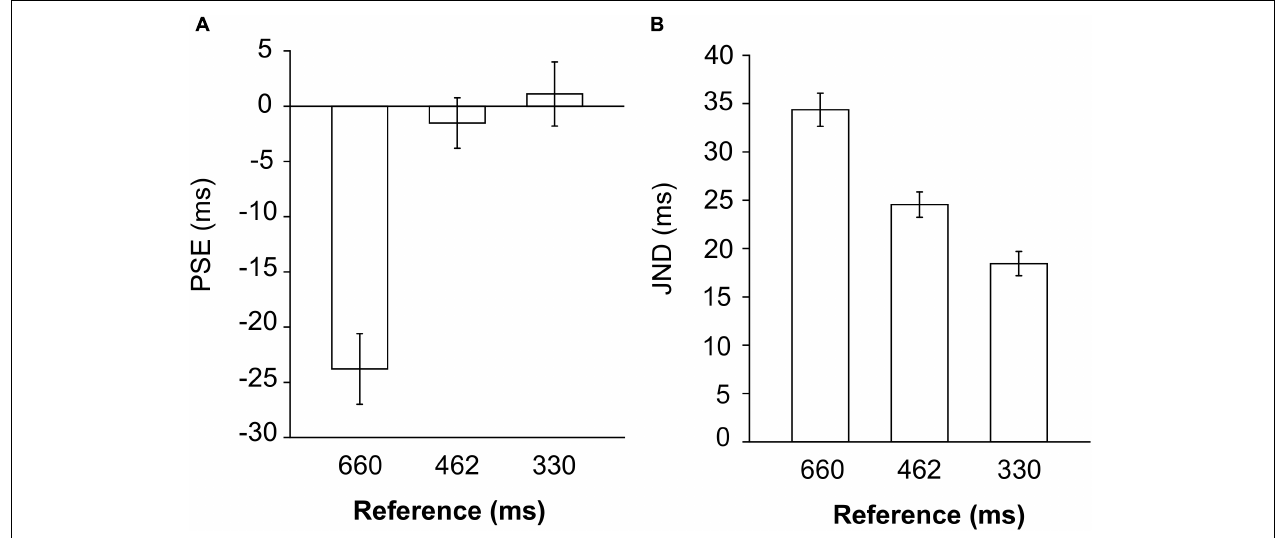
FIGURE 3 | PSE (A) and JND (B) values expressed in milliseconds, measured for each reference interval, averaging the values across regular and non-regular auditory